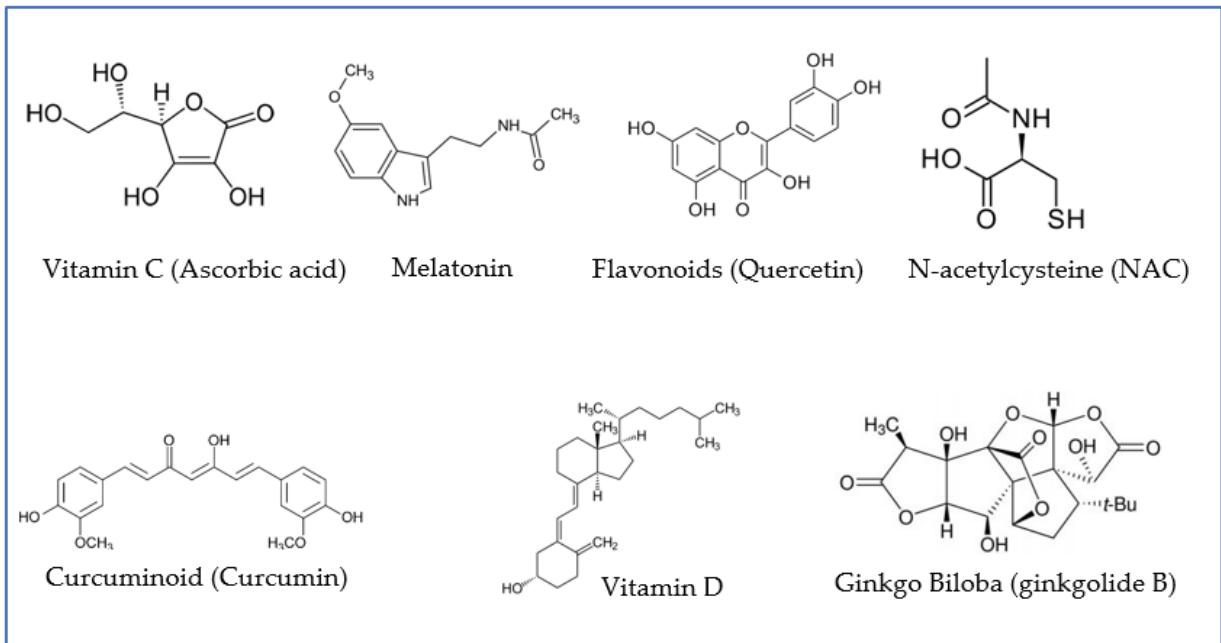
Figure 3. Examples of antioxidant agents with neuroprotective properties that have been proven to play a role in preventive and/or adjuvant therapies for patients infected with COVID-19. Quercetin is presented as an example of flavonoids; ginkgolide B, as an example of terpenoid, derivative of ginkgo biloba; and curcumin, as an example of curcuminoid.